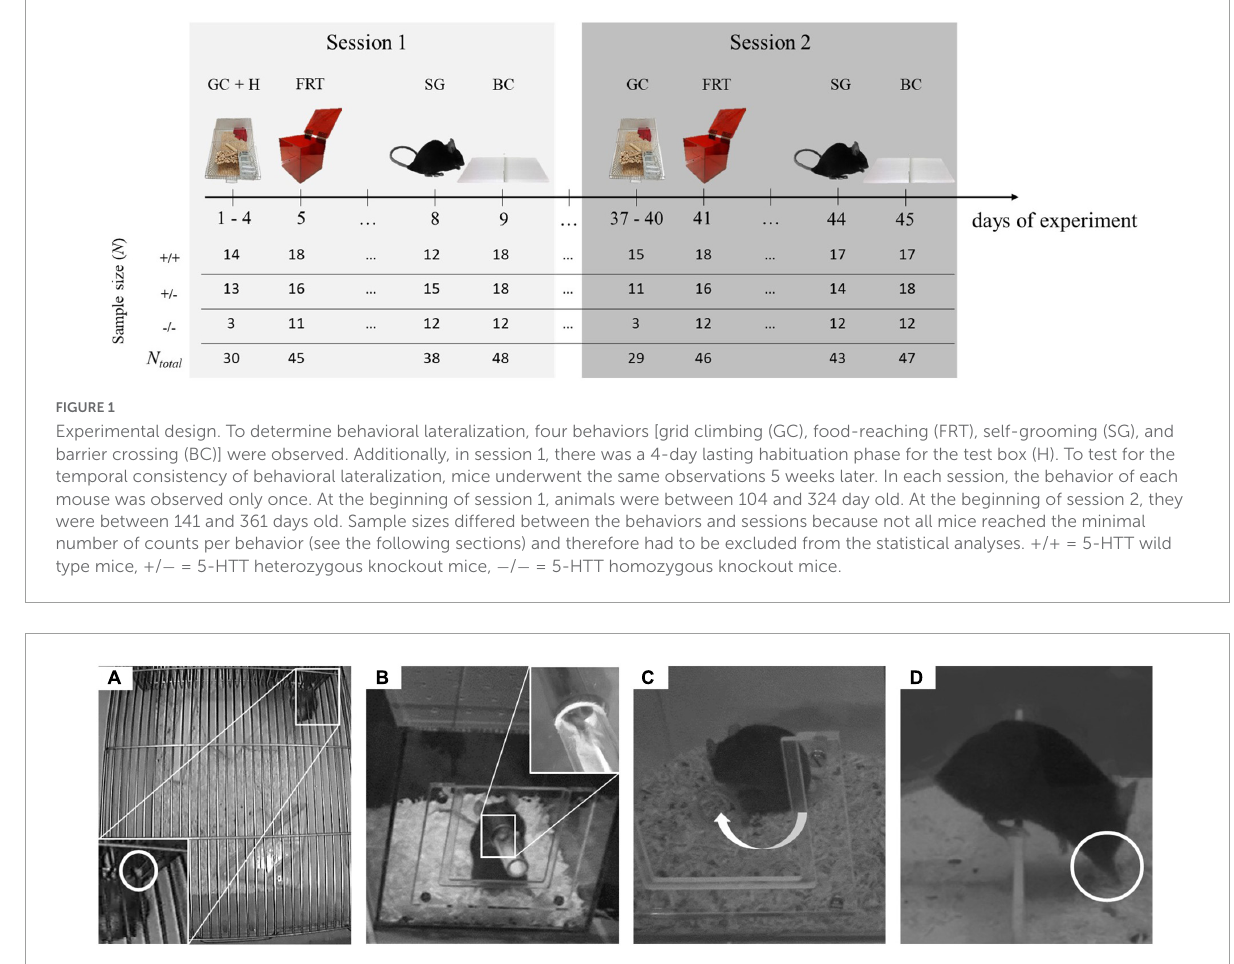
FIGURE2 Behavioral observations. In the experiment, four behaviors were observed. (A) The paw that was used for commencing grid climbing (GC) was observed. (B) In the food-reaching test (FRT), the paw used to reach for food in the feeding tube was counted. (C) The turning side for self-grooming (SG) the tail was noted. (D) Whilst crossing a barrier (BC), the paw that was used by mice to descend the barrier was